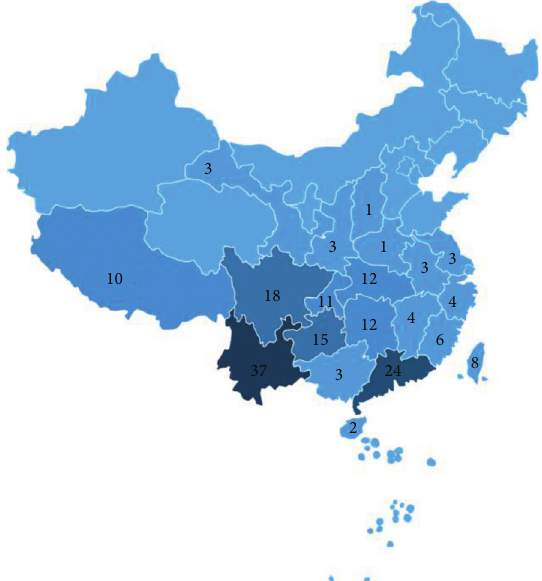
Figure 1: The area distribution of Litsea pungens Hemsl. [3–19]. Numbers presented in each province in the map of China represent the Litsea pungens Hemsl.